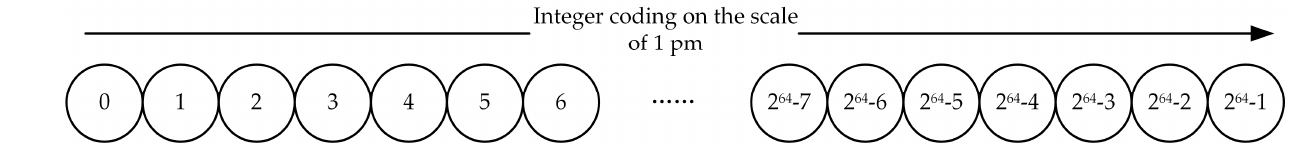
Figure 4. Integer coding at 1 pm scale.